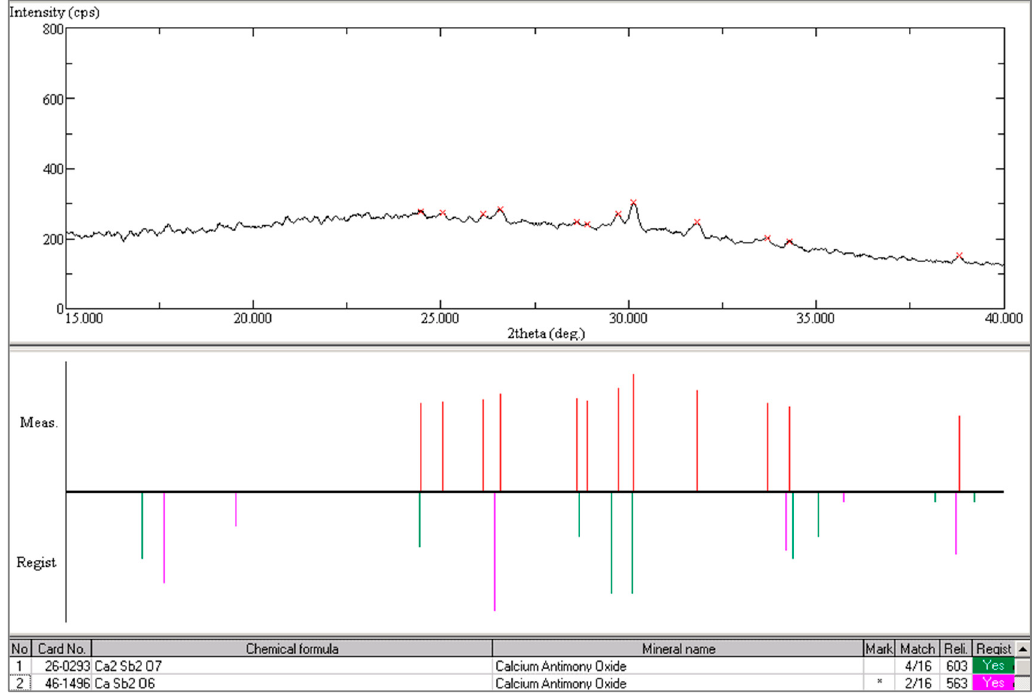
Figure 8. X-ray diffraction pattern demonstrating the presence of both cubic Ca 2 Sb 2 O 7 and hexagonal CaSb 2 O 6 phases in the glass (SSV_B1 blue sample from the monastery of San Severo in Classe, Ravenna, Italy—unpublished data).